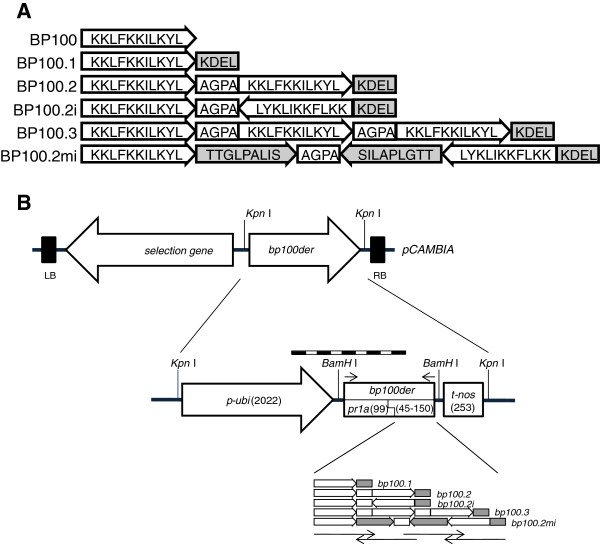
Schematic representation of the BP100 derivatives designed and the components of transgene cassettes in plasmids used for rice transformation.(A) White arrow, BP100; grey arrow, mellitin extension (nucleotides 19–18); white rectangle, linker sequence; grey rectangle, ER retention sequence. Arrows indicate the orientation of the sequences. (B)Top, schematic diagram showing the selection (hptII) and bp100der genes in a pCAMBIA1300 plant expression vector. LB and RB, A. tumefaciens left border and right border sequences. Expression of the bp100der genes is driven by the maize ubiquitin promoter (p-ubi), including the first exon and first intron (overall 1061 bp) and the nos terminator (t-nos). The hygromycin phosphotransferase hptII gene was used in combination with the cauliflower mosaic virus 35 S promoter and terminator sequences, p-35 S and t-35 S (overall, 2015 bp). bp100der length is between 2419 and 2569 bp. Center, regulatory and coding elements in the bp100der gene. The different sequence elements are not drawn to scale. Lengths (in base pairs) are indicated in brackets. Dashed box corresponds to the probe used in Southern analysis, and arrows above bp100der indicate RT-qPCR primers. Bottom, sequences encoding the BP100 derivatives: white, AGPA; grey, KDEL; light faded rectangle, BP100; dark faded rectangle, mellitin fragment. Color fading indicates the orientation of each amino acid sequence. Arrows below represent oligonucleotides (corresponding to bp100.3) used for recursive PCR. Restriction sites relevant for cloning are indicated.